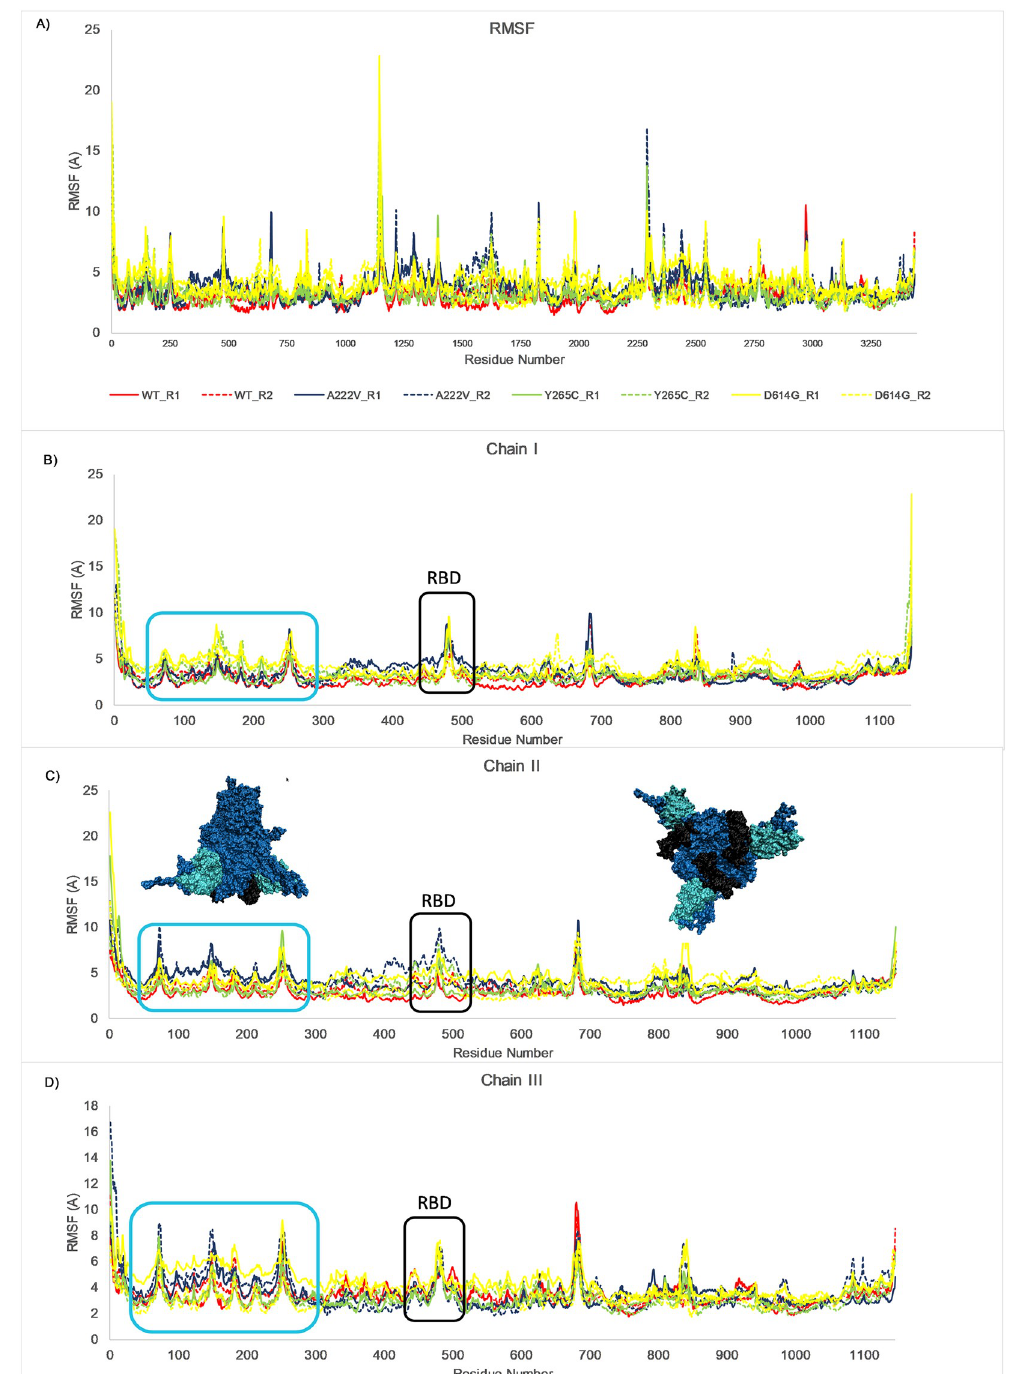
Fig 7. RMSF analysis over 20 ns trajectory. Per residue RMSF values averaged over 20 ns trajectory for (A) spike trimeric protein and its individual (B) Chain I, (C) Chain II. Reference trimeric spike protein 3D-surface rendering from side and bottom, showing the boxed regions, are shown in the inset with the same colors (snapshots exhibit the conformation at T = 20 ns), (D) Chain III. The black box indicates the Receptor Binding Domain residues. The cyan box indicates a highly fluctuating region in all three